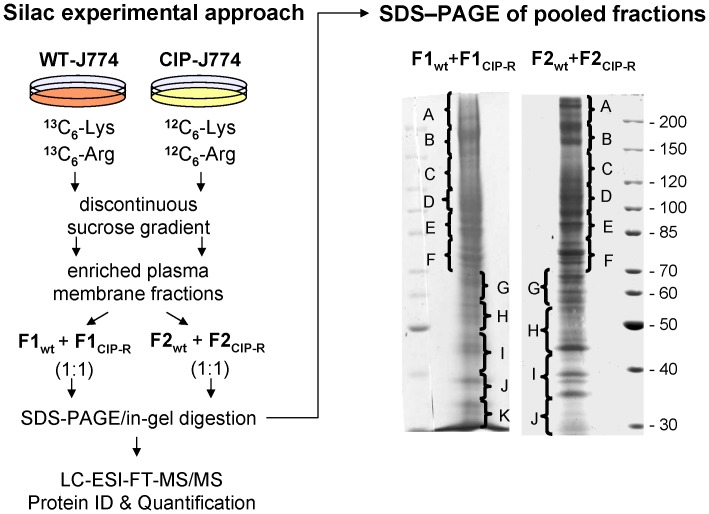
Overview of the SILAC experimental approach.Left: WT-J774 and CIP-R cells were cultured in media containing 13C6-Lys/13C6-Arg and 12C6-Lys/12C6-Arg, respectively. Following isolation of membrane samples for each strain independently, equal amounts from each matching fraction were pooled (F1wt+F1CIP and F2wt+F2CIP) and then separated by SDS-PAGE. Right: Lanes of pooled sample fractions were first cut in sections (A-K for pooled F1 and A-J for pooled F2) and further sliced in thinner, numbered gel plugs which were processed for Trypsine in-gel digestion as described in the experimental procedures. For pooled F1 gel line, section A includes gel plugs from 1 to 8, B 9 to 14, C 15 to 20, C 21 to 24, E 25 to 29, F 33 to 35, G 36 to 41, H 42 to 45, I 46 to 52, J 53 to 60 and K 61 to 65. For sample pooled F2 gel line, section A includes bands 1 to 6, B 7 to 11, C 12 to 18, D 19 to 25, E 26 to 32, F 33 to 39, G 40 to 47, H 48 to 56, I 57 to 65 and J 66 to 72.